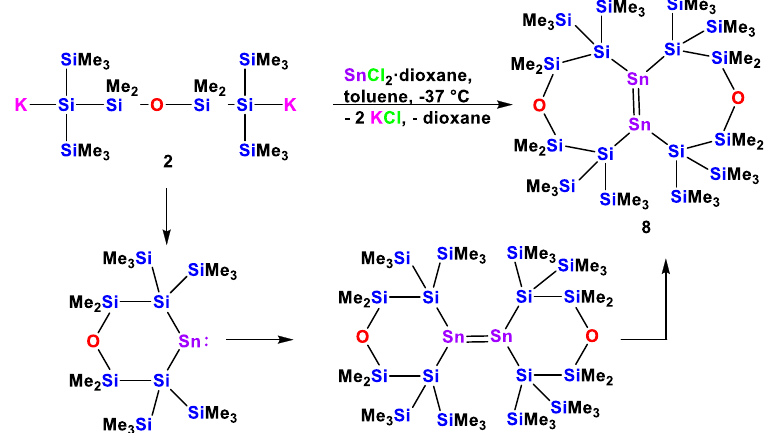
Figure 3. Molecular structure of compound 7 (thermal ellipsoid plot drawn at the 30% probability level). All hydrogen atoms are omitted for clarity (bond lengths in Å, angles in deg). C(1)-P(1) 1.814(3), C(4)-Si(2) 1.866(3), O(1)-Si(3) 1.6378(19), O(1)-Si(2) 1.642(2), P(1)-Sn(1) 2.6059(8), Si(1)-Si(2) 2.3397(11), Si(1)-Sn(1) 2.6464(8), Si(4)-Sn(1) 2.6662(8), Si(3)-O(1)-Si(2) 145.51(13), Si(2)-Si(1)-Sn(1) 96.56(3),